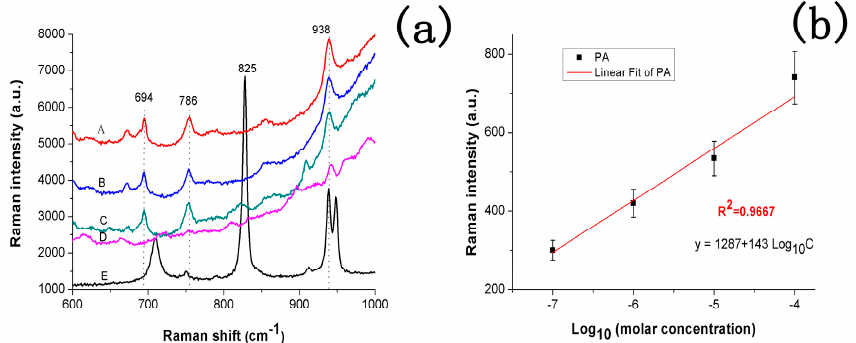
Figure 6. ( a ) SERS signals of PA adsorbed at different concentrations on AgNP-decorated PS PC substrates: (A) 10 − 4 mol/L, (B) 10 − 5 mol/L, (C) 10 − 6 mol/L, (D) 10 − 7 mol/L, (E) solid PA and ( b ) the relationship between the Raman intensity (938 cm − 1 ) and PA concentrations.